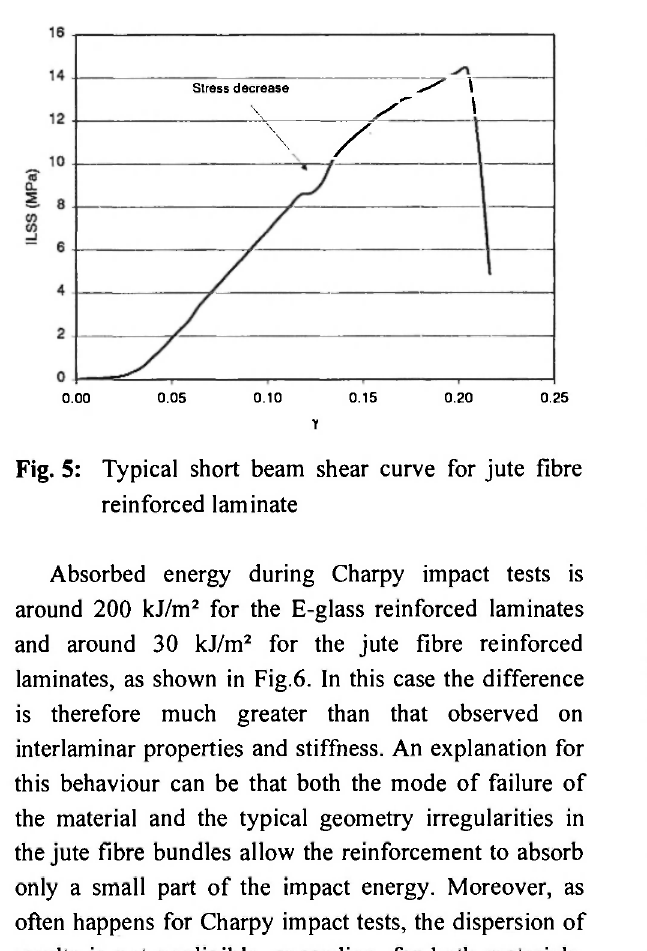
Fig. 5: Typical short beam shear curve for jute fibre reinforced laminate